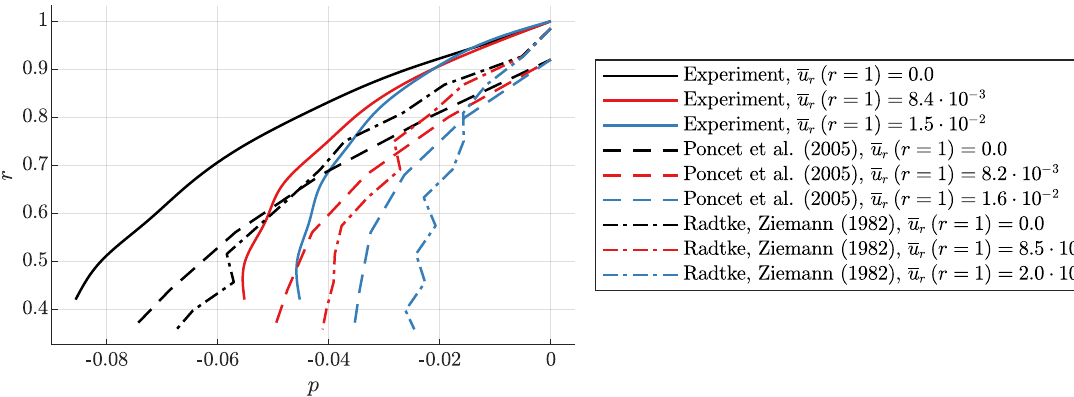
Figure 2. The radial distribution of pressure p with and without centrifugal through-flow at low Reynolds numbers and a small cavity width; the value of G is 0.0125, only Poncet et al. [4] use G =